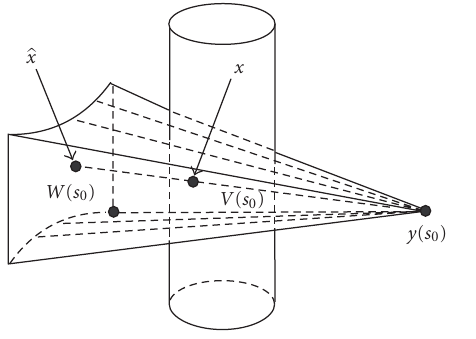
Algorithm 1: Sequential implementation of Katsevich’s FBP inver- sion